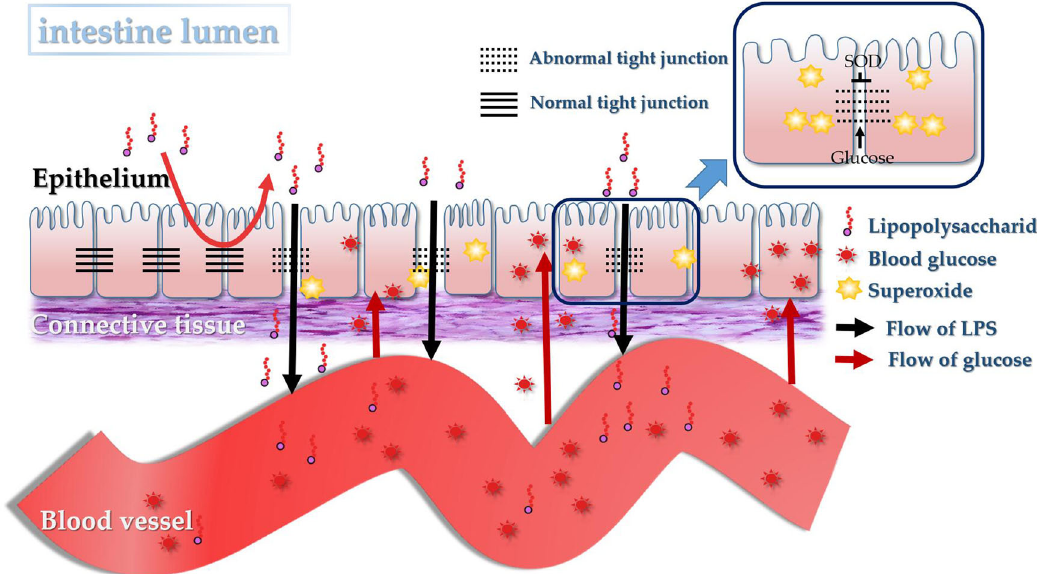
Fig. 10 SOD inhibits hyperglycemia-induced oxidative damage to intestinal barrier integrity. Persistent vascular transport of glucose into intestinal epithelial cells mediates an elevated level of superoxide. This results in increased intestinal permeability via oxidative damage to tight junction-related intestinal barrier integrity, permissive translocation of LPS into systemic circulation, chronic in fl ammation, and IR in T2D. However, oral administration of intestine-targeted SOD can reverse the consequent loss in barrier integrity and systemic in fl ux of LPS, thereby decreasing IR and blood